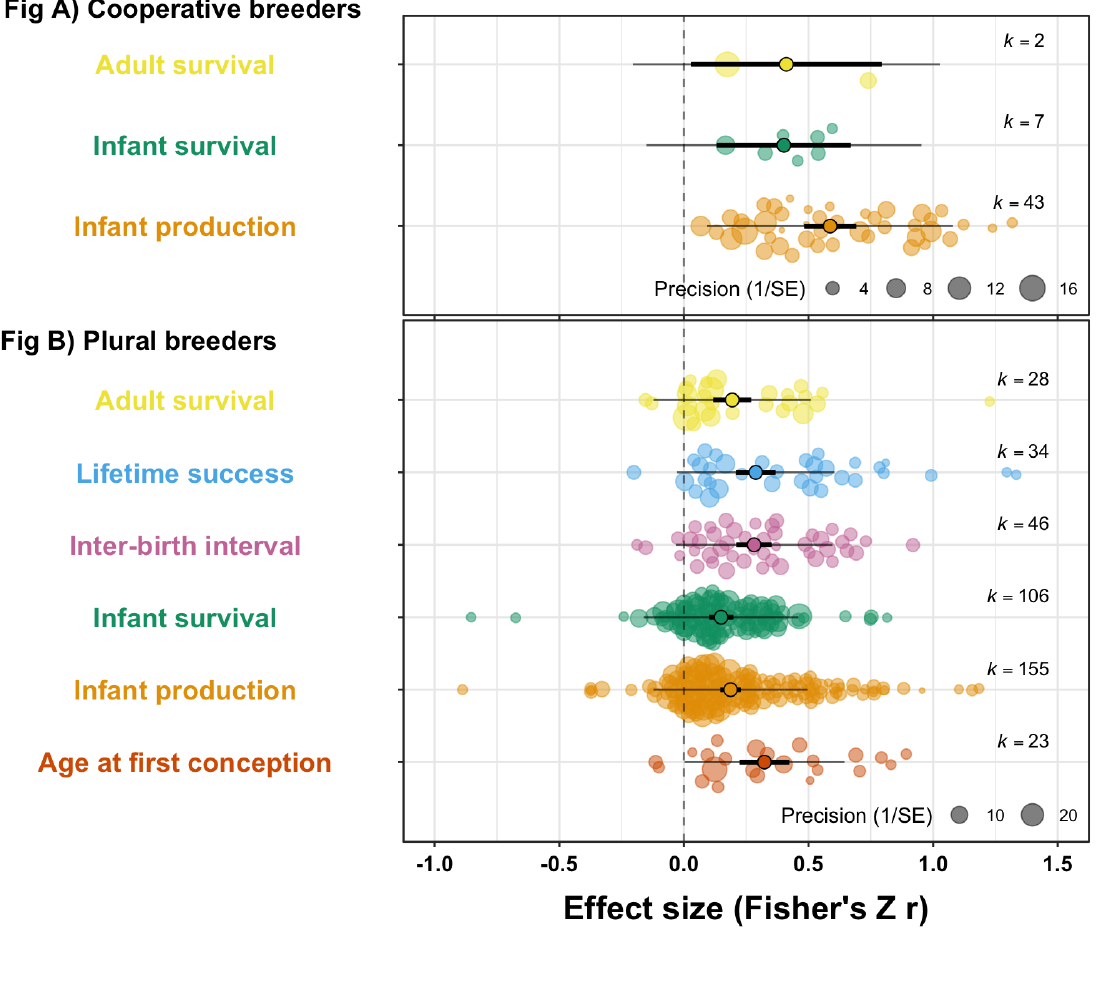
Figure 6. Raw effect sizes of dominance rank on reproductive success are generally higher for cooperative breeders (a) than for plural breeders (b), and differ according to the measure of reproductive success. In general, dominance appears to have stronger effects on reproductive output (lifetime reproductive success, age at first conception, infant production, inter-birth intervals) than on survival (both of the adult females themselves and of their infants). The differences between measures of reproductive success change slightly when accounting for similarity among observations from the same and related species, but the ordering remains the same. As in previous figures, each dot represents a single effect size, with the size of the dot indicating the precision (legend bottom right). For each measure of reproductive success, the darker circle in the middle represents the estimated mean effect, with the bold lines representing the confidence interval of the mean effect and the thinner lines the prediction estimate of the